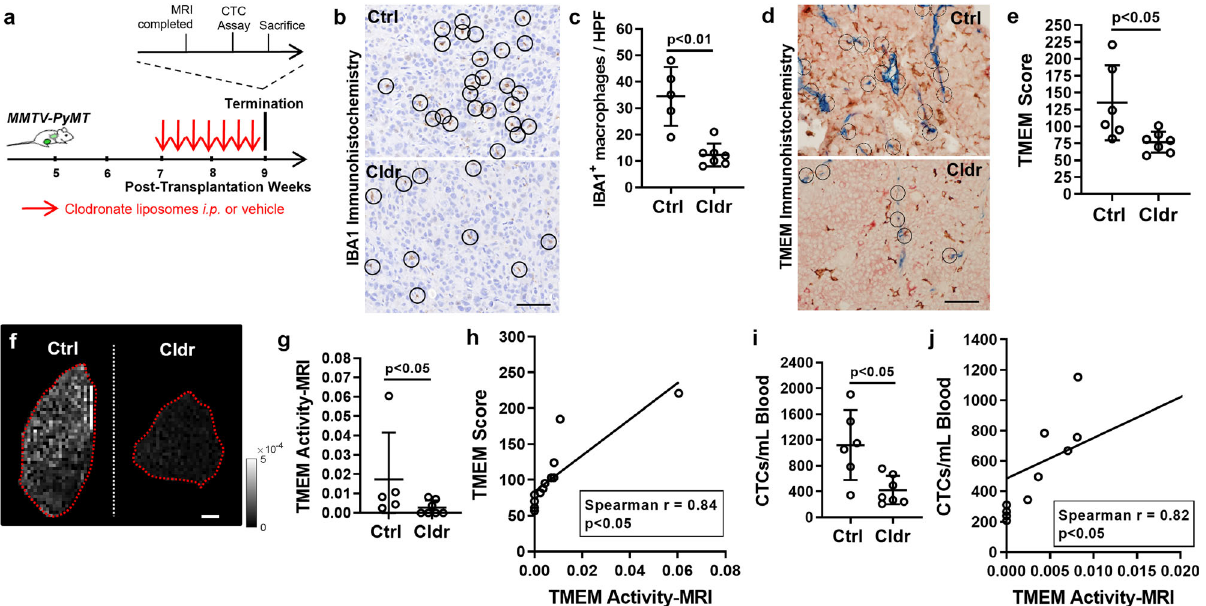
Fig. 2 TMEM activity-MRI is suppressed, as a result of reduced TMEM doorway formation, using clodronate-mediated macrophage depletion. a Experimental strategy and mouse cohort composition for MMTV-PyMT mice subjected to clodronate-dependent macrophage depletion. PyMT Polyoma Middle-T antigen, CTC circulating tumor cell. b Identi fi cation of macrophages by IBA1 immunohistochemistry and representative images from MMTV-PyMT mice, treated with either control or clodronate liposomes. Scale = 100 um. c Quanti fi cation of IBA1 + macrophages, as averaged in 10 high-power fi elds (HPFs) in MMTV-PyMT mice shown in ( b ). Mann – Whitney U -test. d TMEM identi fi cation by triple-stain immunohistochemistry (IHC) and representative images from MMTV-PyMT mice, treated with either control or clodronate liposomes. Scale = 100 um. e Quanti fi cation of TMEM doorways (TMEM score), as assessed in 10 high-power fi elds (HPFs), in MMTV-PyMT mice shown in ( d ). Mann – Whitney U -test. f Representative TMEM Activity-MRI maps of mammary carcinoma tumors by magnetic resonance imaging (MRI) from MMTV-PyMT mice treated with clodronate (second column) or vehicle control ( fi rst column). Scale = 1 mm. g Quanti fi cation of TMEM-mediated vascular opening events (TMEM doorway activity), assessed via TMEM Activity-MRI assay in MMTV- PyMT mice shown in ( f ). Mann – Whitney U -test. h Correlation between TMEM score (as quanti fi ed in e ) and TMEM Activity-MRI (as quanti fi ed in g ) in MMTV-PyMT mice treated with either control or clodronate liposomes. Spearman ’ s rank correlation coef fi cient. i Circulating tumor cell (CTC) counts in MMTV-PyMT mice treated with either control or clodronate liposomes. Mann – Whitney U -test. j Correlation of TMEM activity-MRI score with circulating tumor cells (CTCs) in MMTV-PyMT mice, treated with either control or clodronate liposomes. Spearman ’ s rank correlation coef fi cient. Error bars: standard deviation